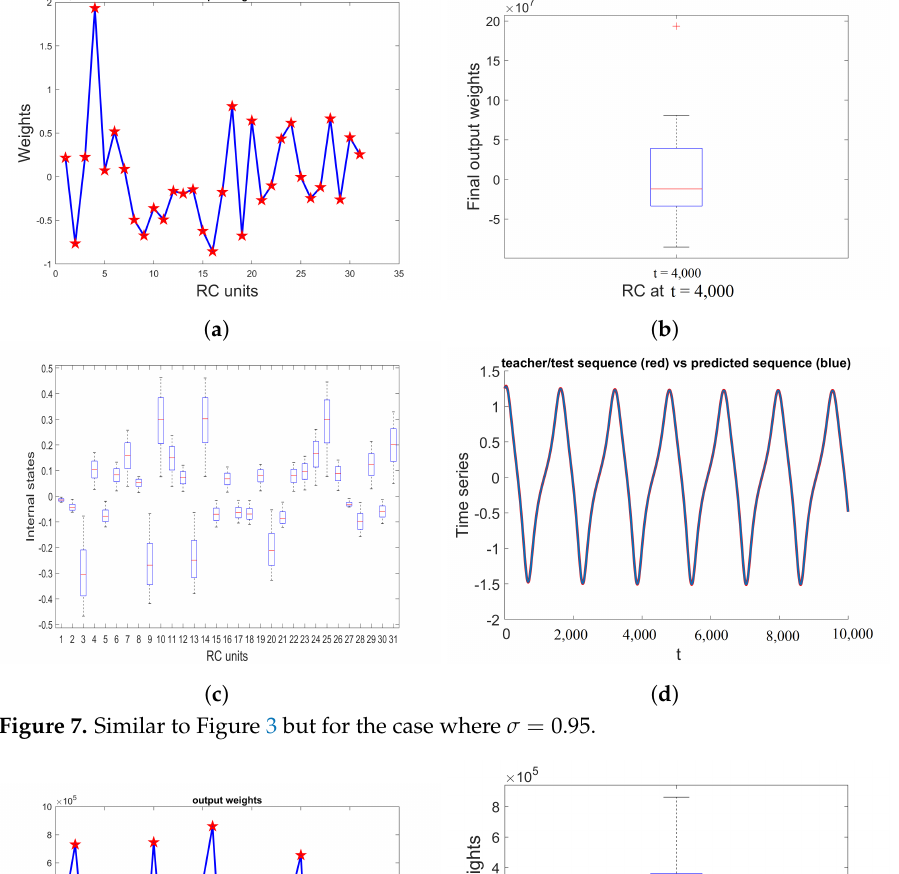
Figure 7. Similar to Figure 3 but for the case where σ = 0.95.